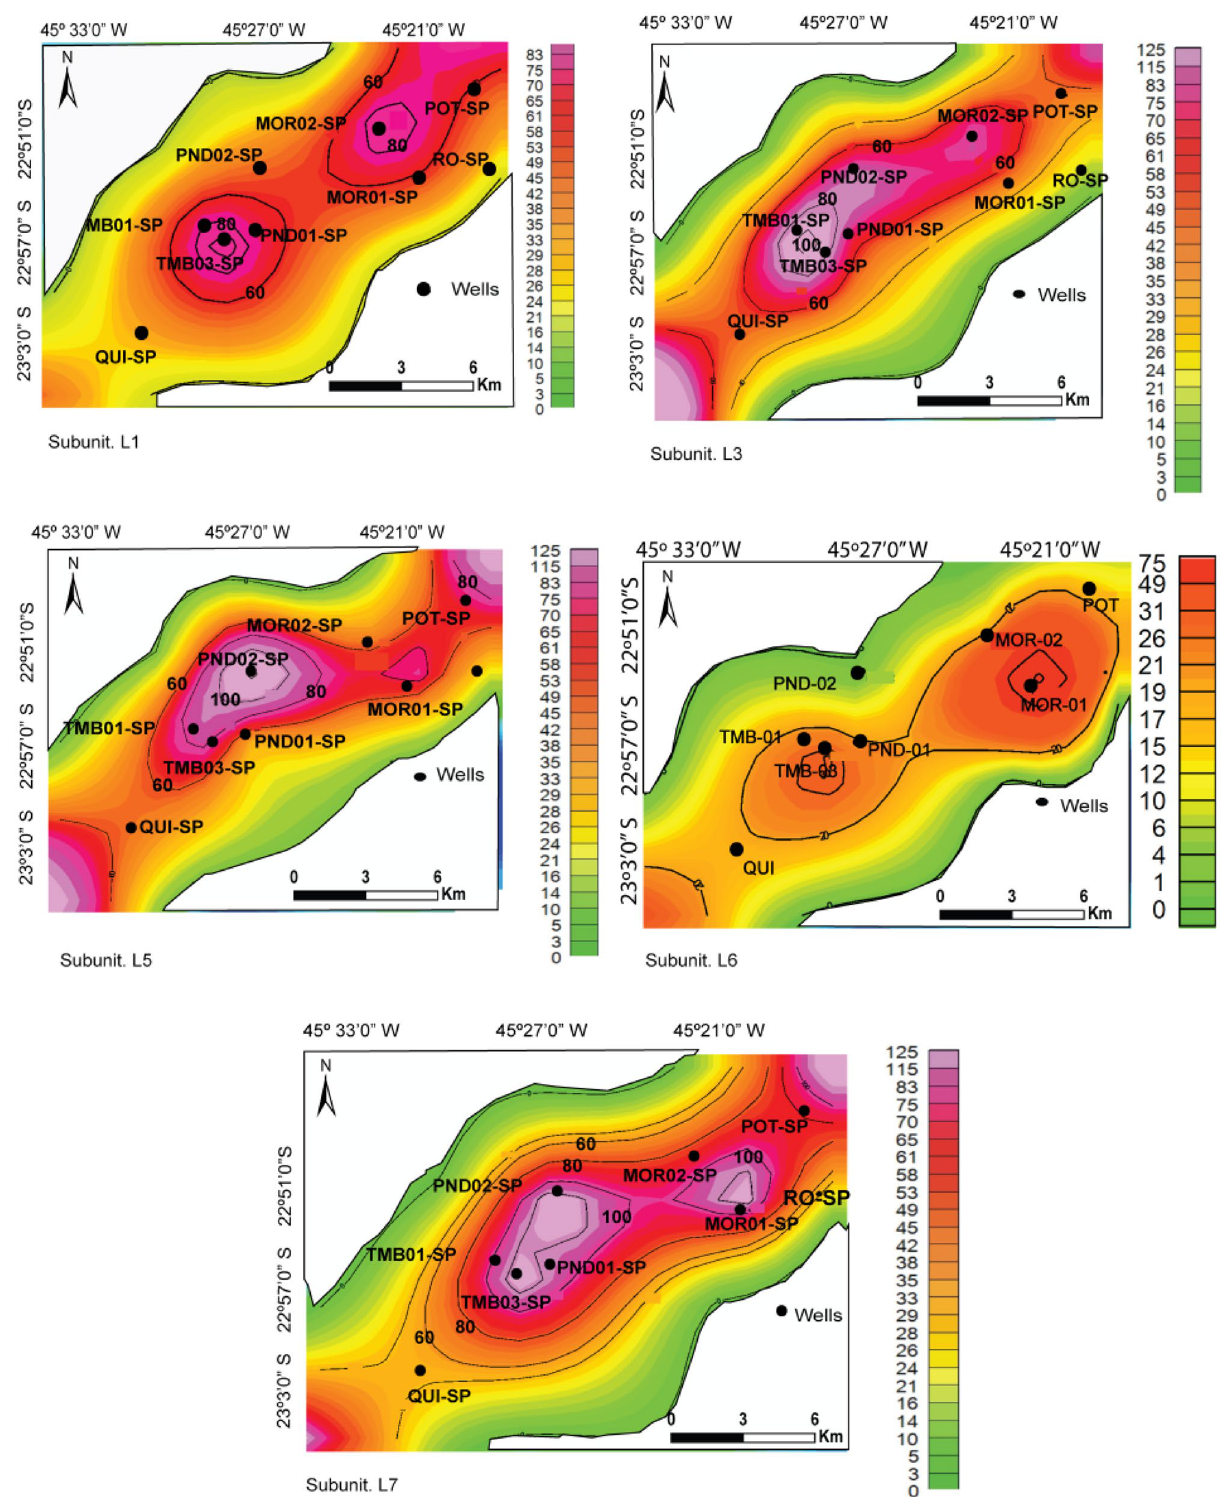
Fig. 8 Map of yield distribution (S1 + S2, in mg HC/g rock), by subunit, utilized to estimate the average of the areas and their standard deviation. The isolines of 60, 80 and 100 mg/g show the respective areas enclosed, utilized in the Monte Carlo